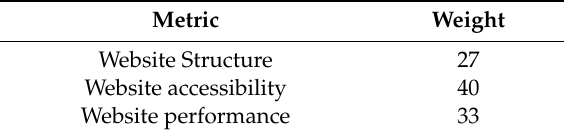
Table 5. Weights for the calculation of the overall website quality evaluation